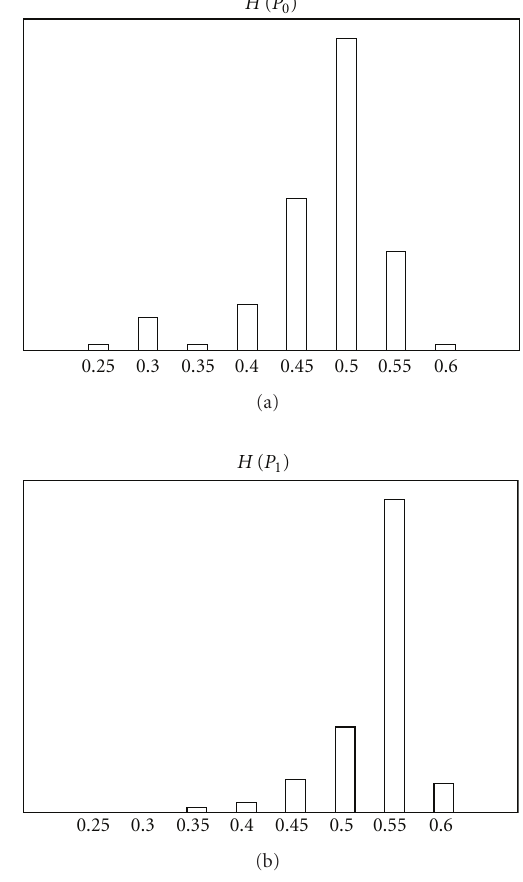
Figure 6: H (control) and H (aesthetic) histograms.